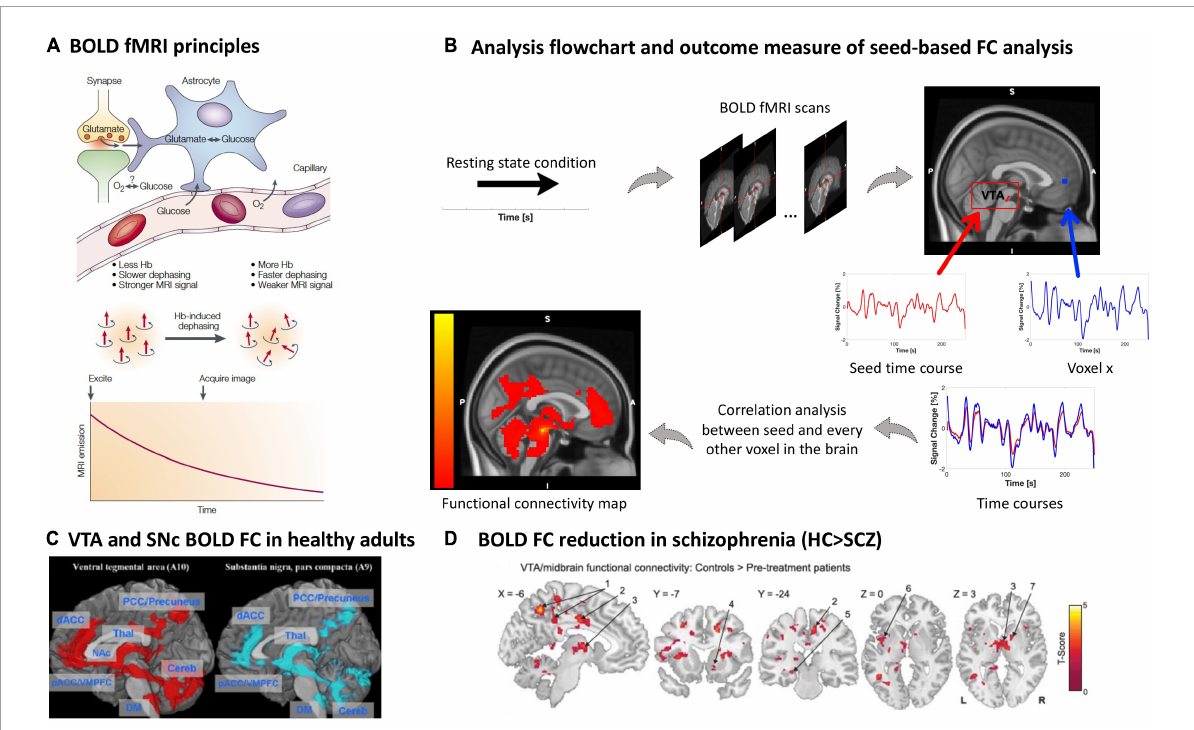
FIGURE5 Blood oxygenation MRI of dopaminergic nuclei and their BOLD resting-state functional connectivity in schizophrenia. (A) BOLD fMRI principles. The figure shows the proposed relationship between neurophysiological underpinnings of BOLD signal fluctuation along time, i.e., synaptic activity, neurotransmitter recycling and metabolic demand (above), and the physical underpinning of the T2*-weighted imaging-based effect of deoxyhemoglobin on the MRI signal (below) [adapted with permission from (121)]. (B) Analysis flow chart and outcome measure of seed-based FC analysis. To investigate the functional architecture of the dopaminergic system during resting state, a region of interest is selected as a seed, for example the VTA. The delineation of the seed can be done via manual segmentation, created based on a specific MNI coordinate or based on a mask derived from an atlas, e.g., as in this example (170). Next, a correlation coefficient (e.g., Pearson’s) is calculated between the seed’s time course and every other voxel in the rest of the brain, creating individual seed-wise FC maps as outcome (125, 126). (C) VTA and SNc BOLD FC in healthy adults. Positive whole-brain resting state FC analysis of the VTA and SNc. All comparisons were thresholded at an FWE-corrected voxel-level significance of p < 0.05 and at an FDR-corrected cluster-level significance of p < 0.05. pACC, perigenual anterior cingulate cortex; dACC, dorsal anterior cingulate cortex; PCC, posterior cingulate cortex; VMPFC, ventromedial prefrontal cortex; NAc, nucleus accumbens; THAL, thalamus; Cereb, cerebellum; DM, dorsal medulla [adapted with permission from (171)]. (D) BOLD FC reduction in schizophrenia. Regions showing VTA/midbrain connectivity in controls ( n = 21) compared to pre-treatment unmedicated patients with schizophrenia ( n = 21); two tailed two sample t -test corrected with a false discovery rate (FDR) at p < 0.05 [adapted with permission from